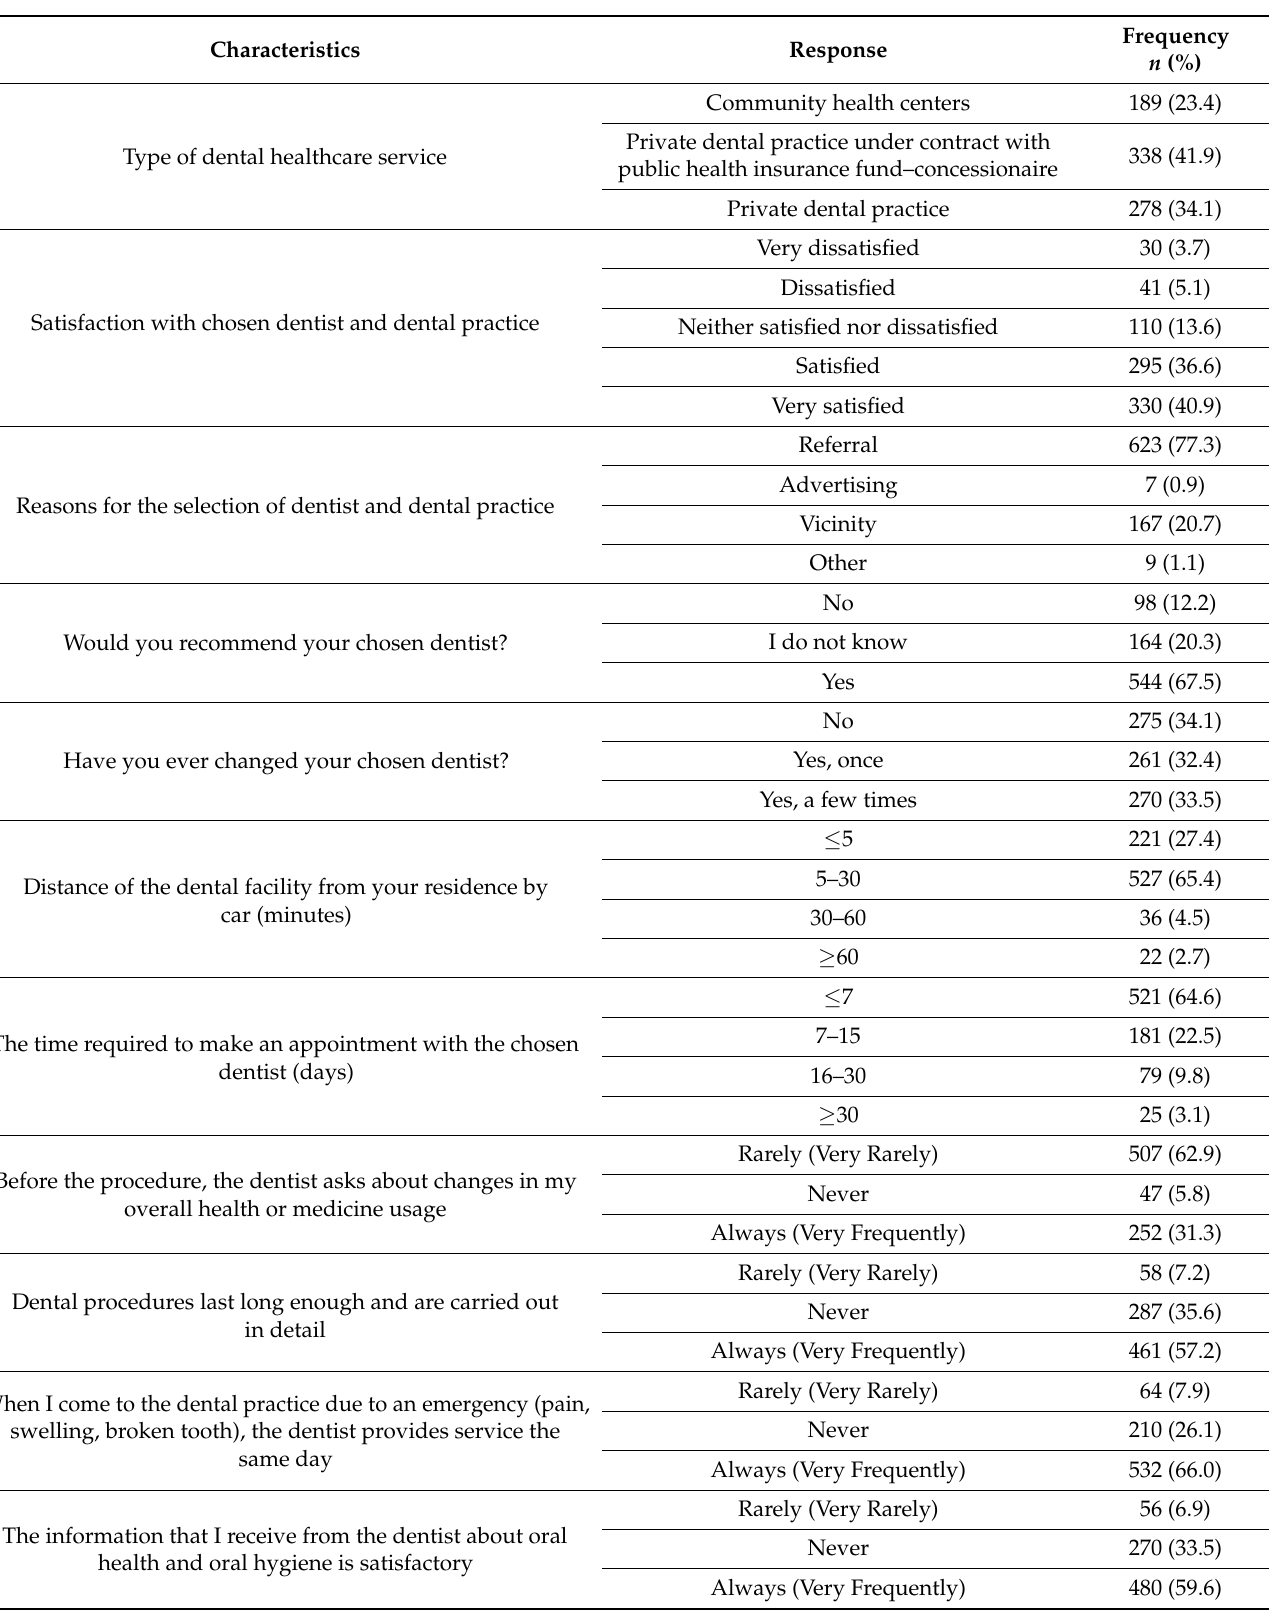
Table 2. Respondents’ attitudes regarding chosen dentist, dental practice and dental services provided ( n =